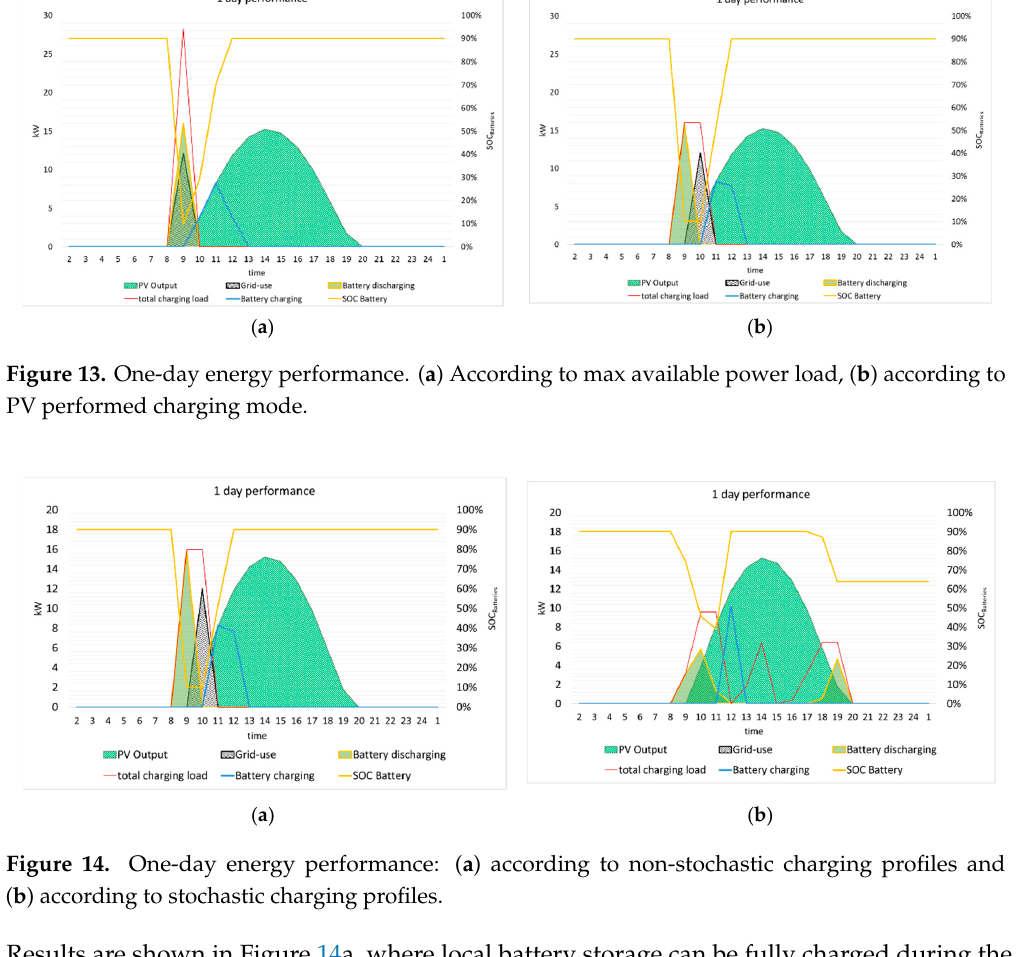
Figure 15. One-day energy performance of the charging station when driven distance is increased to 80 km/day.